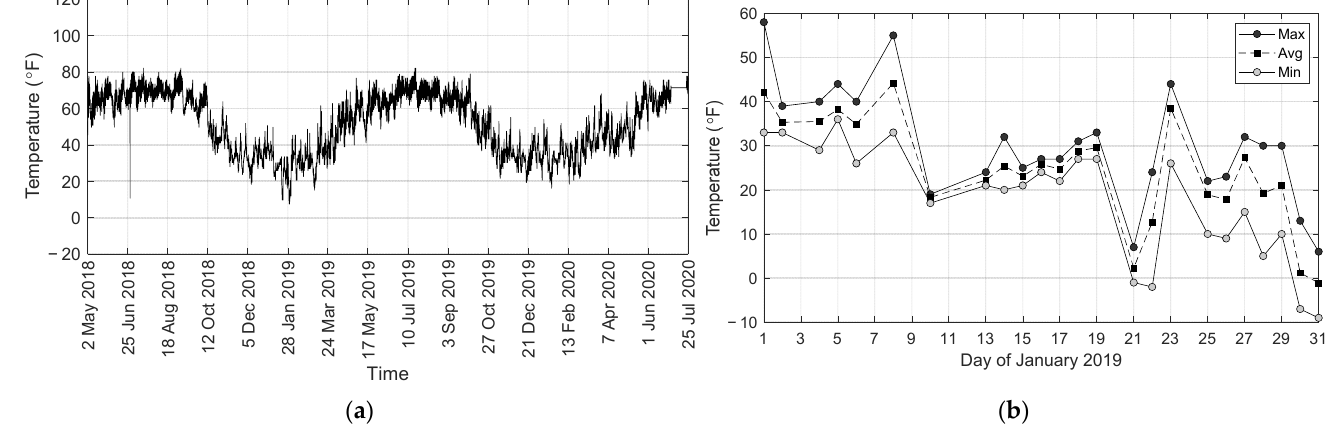
Figure 11. ( a ) Raw temperature recorded by gauge S02 during the long-term monitoring; ( b ) tem- peratures recorded by a weather station near the bridge during January 2019. Figure 12 shows the raw strain vs. the raw temperature collected for S02 and S29. Each graph contains the lines bounding the ±4 σ interval and a thick red line that indicates linear regression. Instead of commonly used 3 σ , here the choice of four times the stand- ard deviations was used for better visualization of the distribution and also more effec- tive/realistic outlier analysis. The equation of this red line and the corresponding R 2 value are provided as well. If each individual concrete box beam was free to expand/contract without lateral confinement, the slope of the equation could have been linked to a kind of composite coefficient of linear thermal expansion.